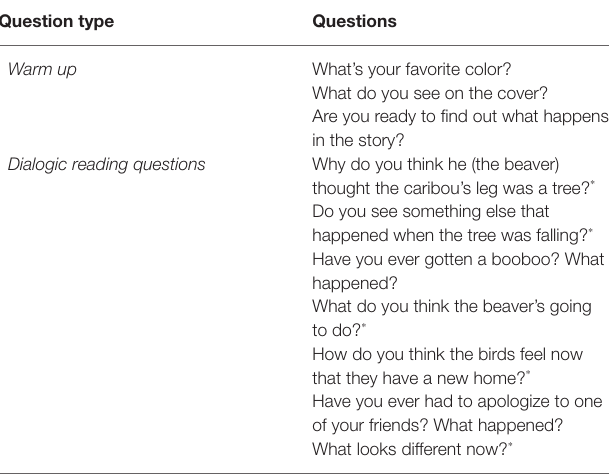
TABLE 3 | Questions posed during book reading. Question type